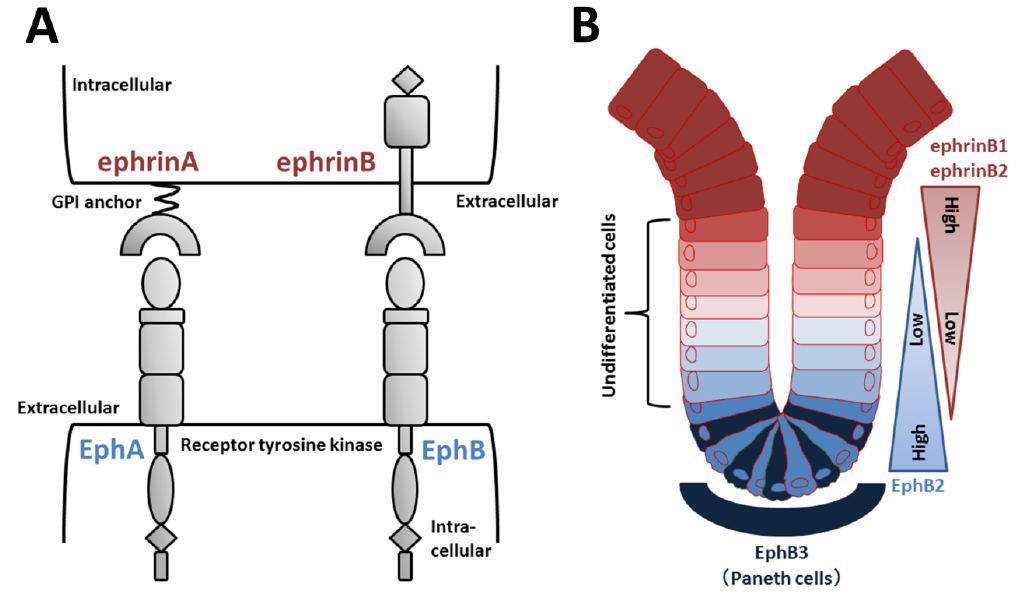
Figure 4. Eph/ephrin structure and regulation of EphB/ephrinB signaling in intestinal crypts. ( A ) Domain organization of Eph receptors and ephrin ligands. EphA receptors typically bind to ephrinA (GPI-anchored) ligands, and EphB receptors bind to ephrinB ligands. ( B ) EphB2-positive stem and undifferentiated cells are located near the bottom of intestinal crypts, whereas ephrinB1/B2-positive differentiated epithelial cells are concentrated at the crypt-villus boundary. In the small intestine, EphB3-expressing Paneth cells are found at the crypt bottom.